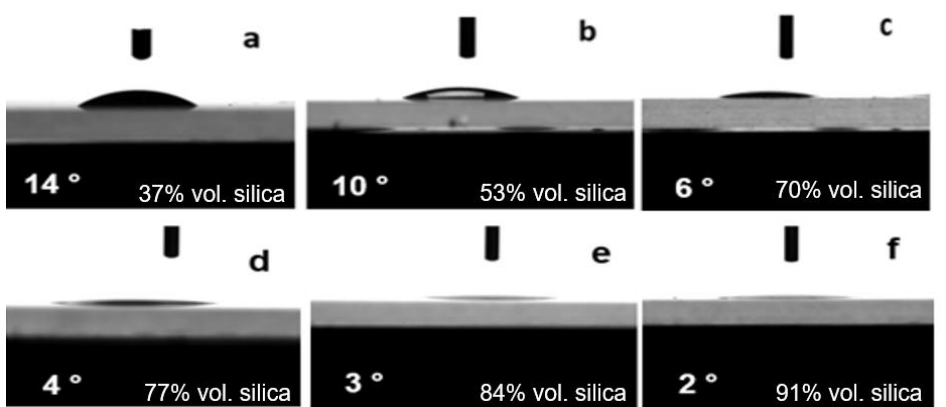
Figure 2. Variation of equilibrium water contact angle of coatings with particle loading (vol. %) of ( a ) 37, ( b ) 53, ( c ) 70, ( d ) 77, ( e ) 84, ( f ) 91.